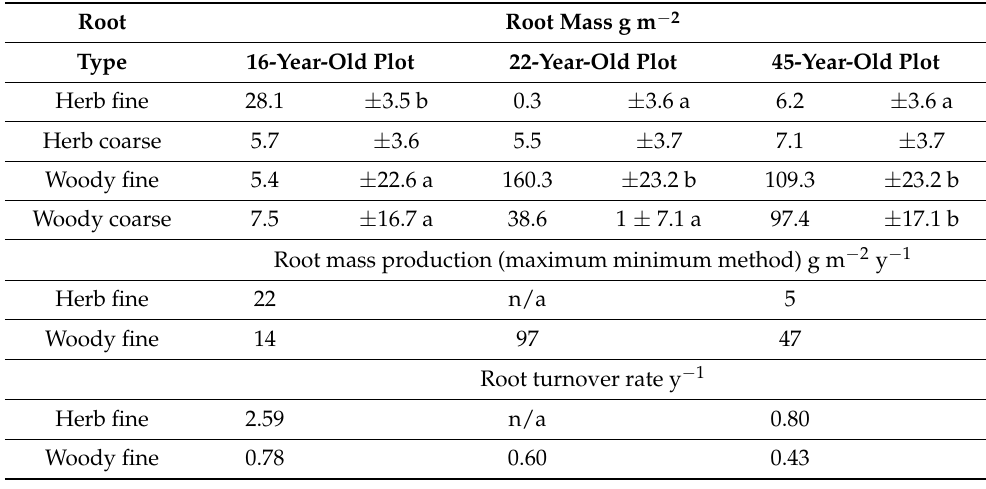
Figure 2. Depth distribution of woody and herbaceous roots in post-mining sites created 6- ( a ), 16- ( b ), 22- ( c ) and 45-years ago ( d ) in the Sokolov coal mining district and left to develop by spontaneous succession. If present, the fermentation layer on the soil surface (F) was also sampled and roots were quantified the same way as in soil layers. Table 2. Mean root biomass and root length in 16-, 22-, and 45-year-old post-mining sites ± SEM, based on all sampling occasions ( n = 24 for each site) in the whole soil profile measured. Root production was estimated by the maximum–minimum method, and root turnover was calculated as production divided by mean biomass. Statistically homogeneous groups of sites are marked by the same letter (one-way ANOVA, LSD post hoc